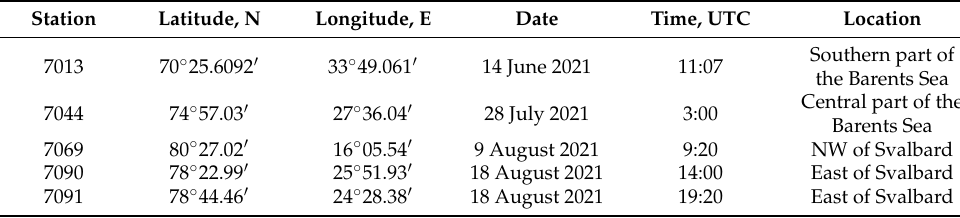
Table 1. Information about the selected